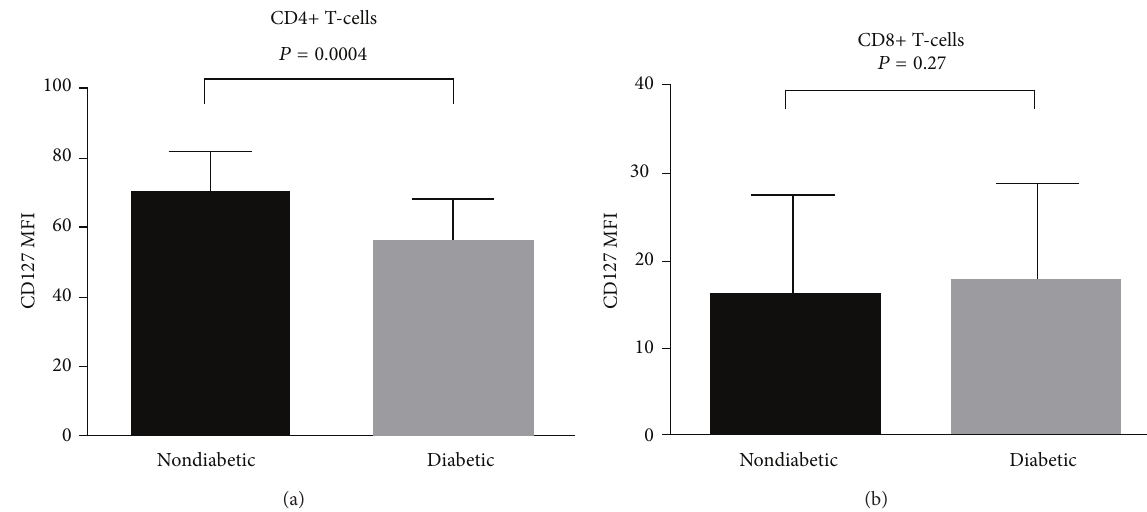
Figure2:ComparativeanalysisofCD127expressiononCD4+andCD8+T-cellsinhealthycontrolsandT1Dpediatricpatients.Barsrepresent medians while whiskers represent interquartile range. MFI: mean fluorescence intensity.